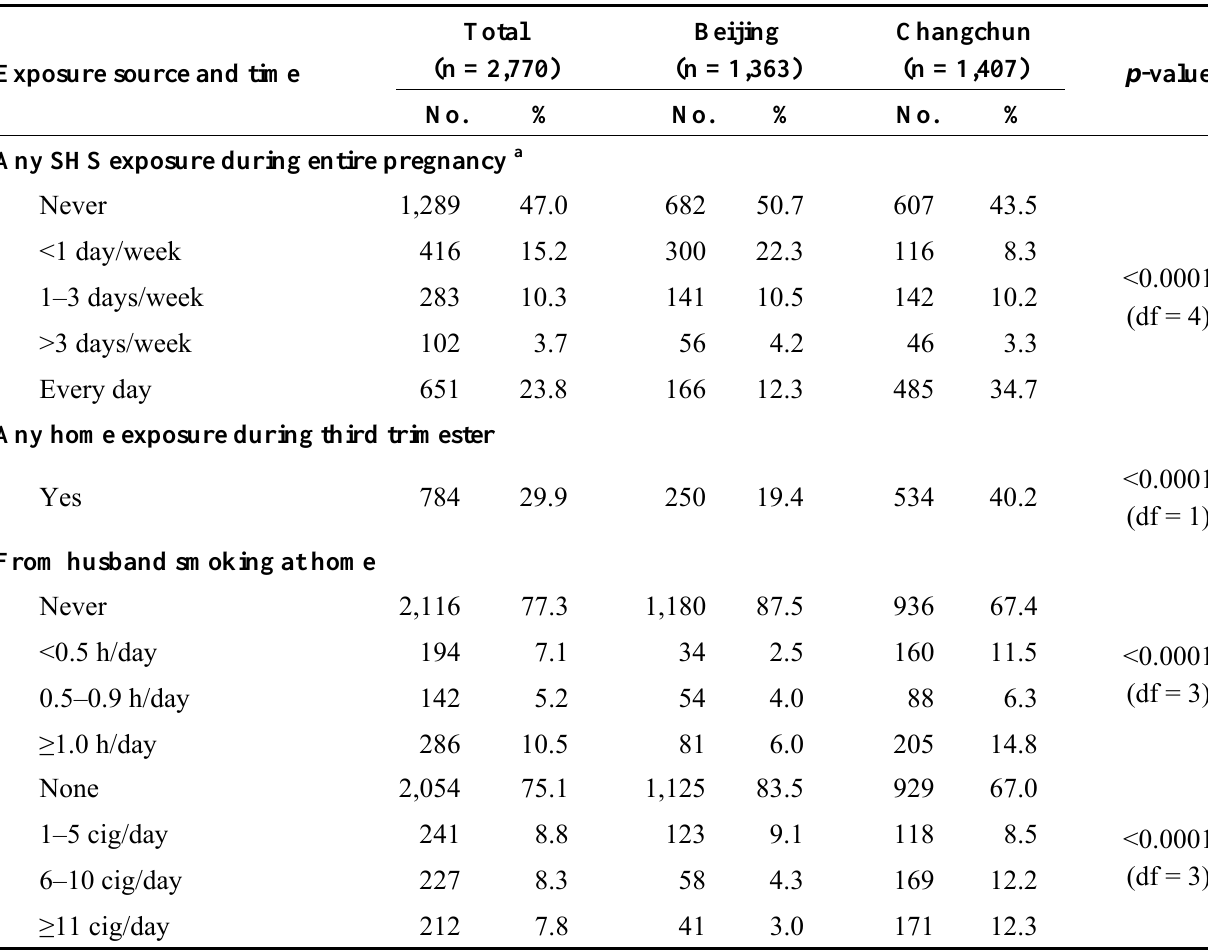
Table 5. Self-reported daily average exposures to SHS during third trimester of